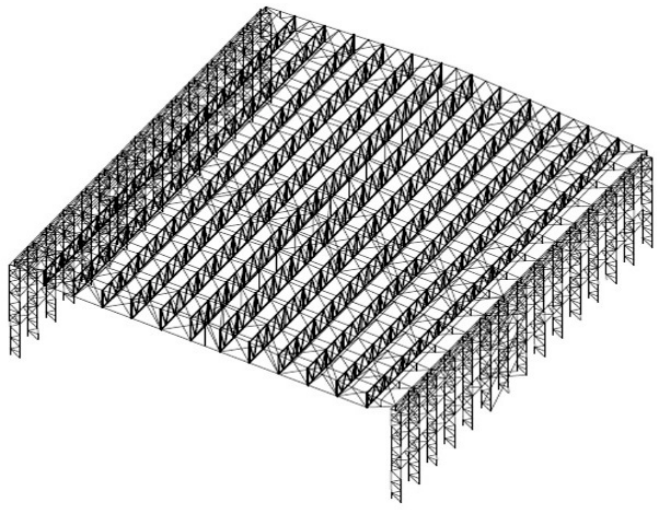
18 of 23 Figure 24. Diagram of the distribution of the dynamic coe ffi cient in case of damage of the lower chord. The fi gure shows that the maximum value of the dynamic coe ffi cient corresponds to the damaged truss. The calculations showed that the dynamic coe ffi cient in neighboring farms ranges from 1.036 to 1.075. For subsequent trusses, the dynamic forces practically do not change and range from 1.011 to 1.071. Thus, in the considered structural scheme of the frame with local destruction of one of the elements of the truss, the redistribution of e ff orts occurs within the limits of the damaged truss. This explains the signi fi cantly lower values of the dynamic coe ffi cients for neighboring farms. With this design scheme, an increase in the survivability of the frame